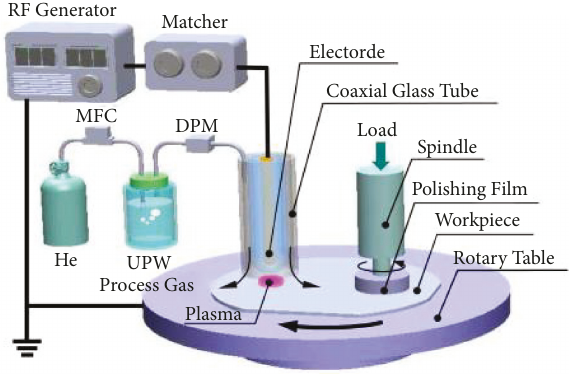
Figure 19: Schematic of experimental device [92].